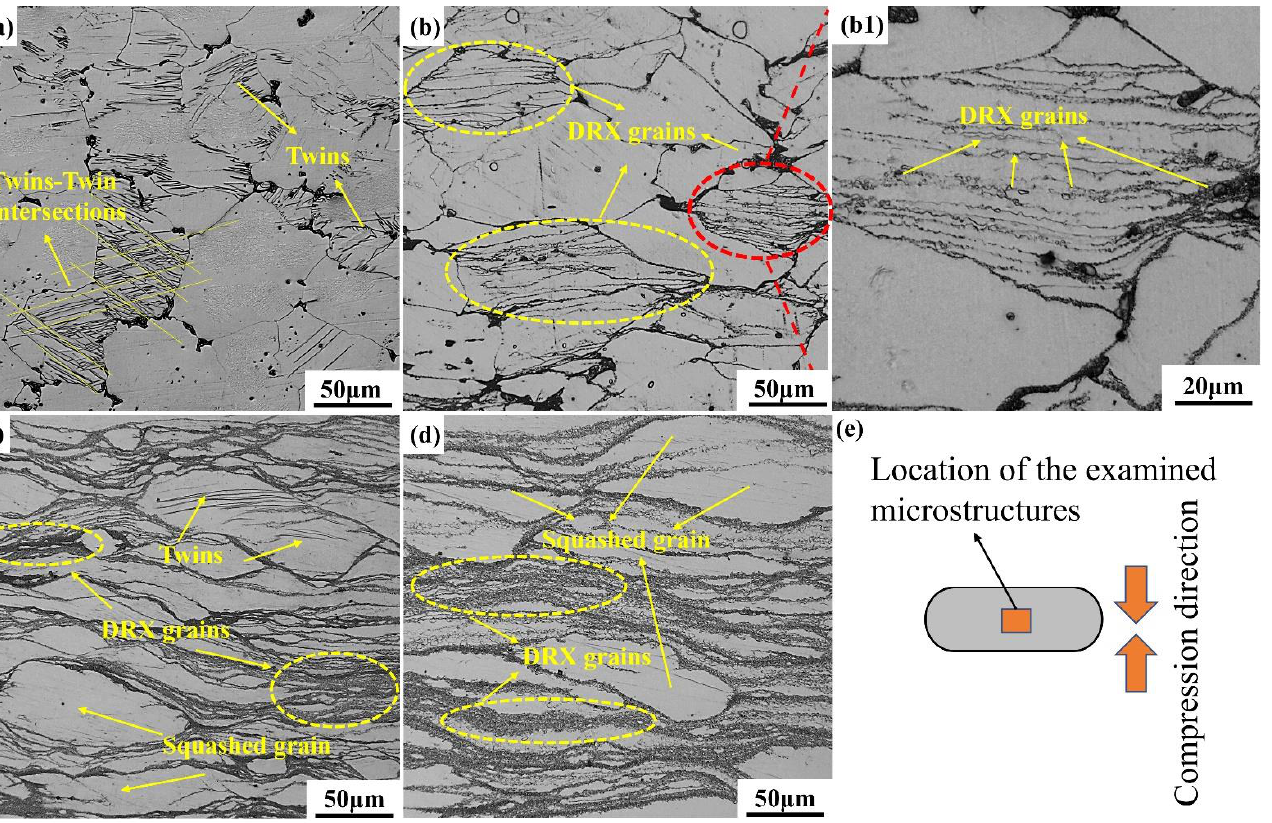
Figure 14. Microstructure of compressed samples with strain rate is 0.02 s −1 at 300 °C: ( a ) ε = 0.1, ( b ) ε = 0.3, ( c ) ε = 0.7, ( d ) ε = 0.9, ( b1 ) The bigger magnification microstructure of ( b ), ( e ) Schematic diagram of the location of the examined microstructures.